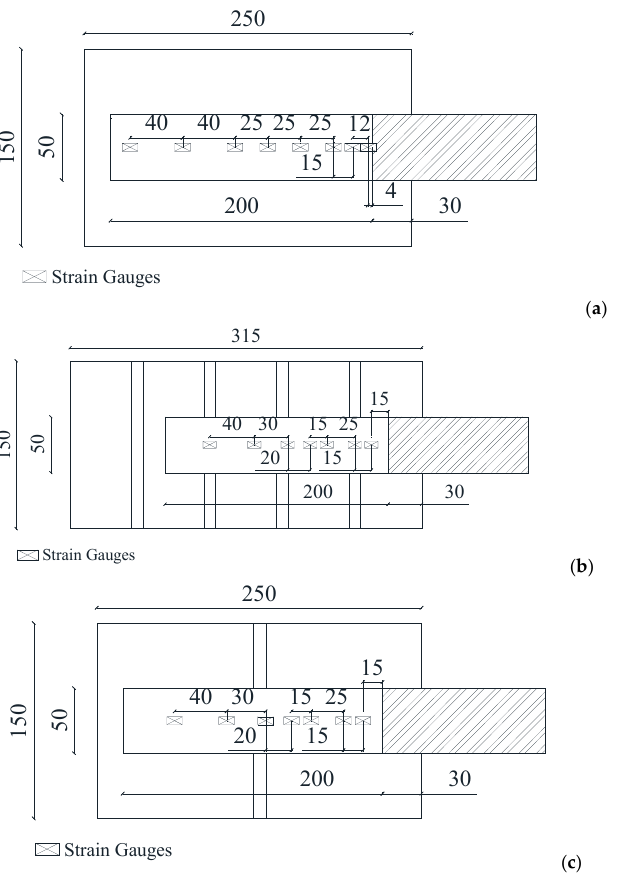
Figure 2. Dimensions of specimens and strain gauge setup: ( a ) stone unit; ( b ) stone masonry unit with five stone units; ( c ) stone masonry unit with two stone